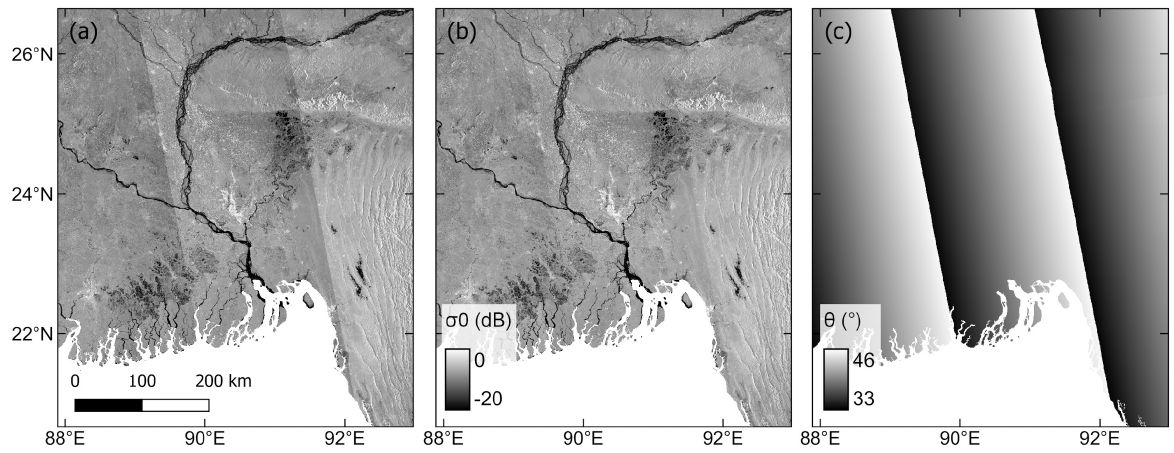
Figure 3. Image example of cosine squared normalization on three ascending tracks of Sentinel-1 VV polarisation in Bangladesh. The images are acquired between 1 and 12 December 2021. The ocean is masked out. (a) the original σ 0 image. (b) σ 0 image corrected to an incidence angle of 35 ◦ . (c) incidence angle.